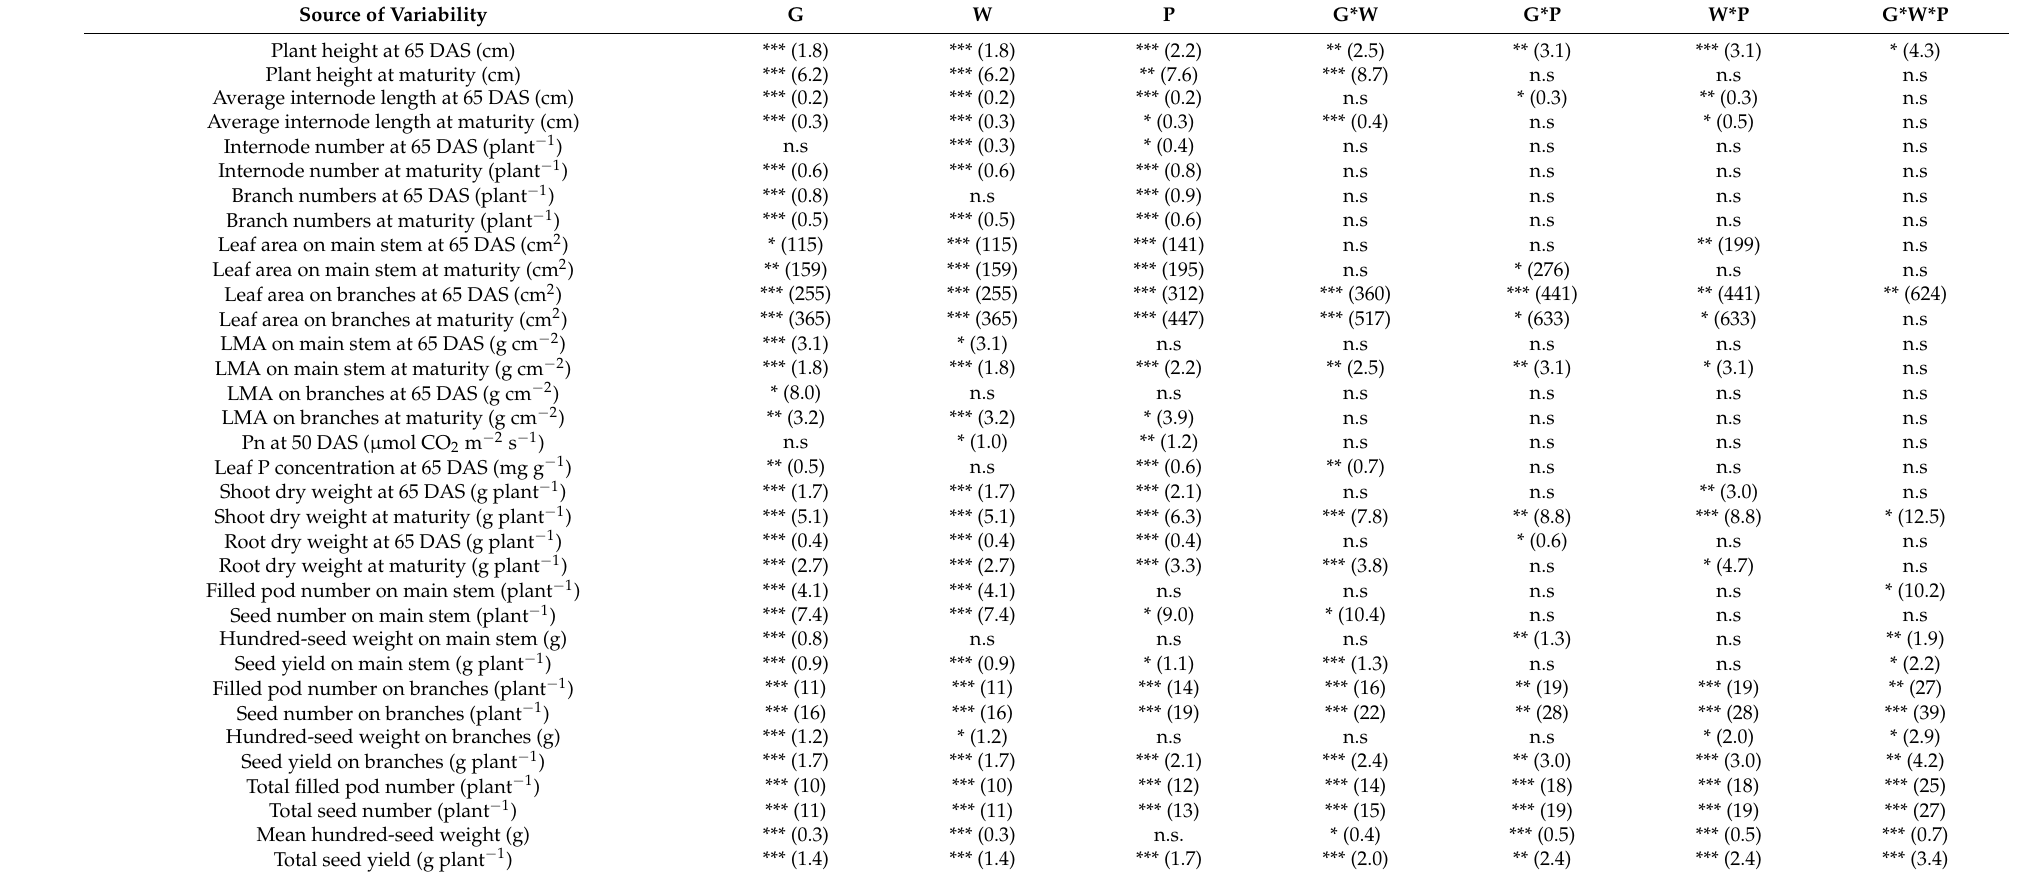
Table 1. Significance of sources of variability for genotypes (G), water treatments (W) and phosphorus levels (P), and their interactions for Huangsedadou (HD) and Zhonghuang 30 (ZH) under two water regimes (well-watered (WW) and cyclic water stress (WS)) and three P levels (0 (P0), 60 (P60) and 120 (P120) mg P kg − 1 dry soil). n.s. not significant, * p < 0.05, ** p < 0.01, *** p < 0.001. LSD values at p = 0.05 are in